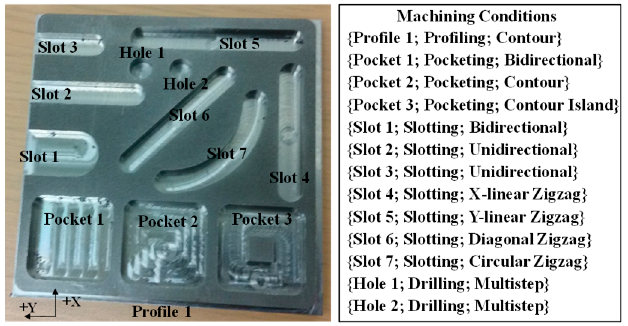
Figure 10. A test part and a set of machining conditions.